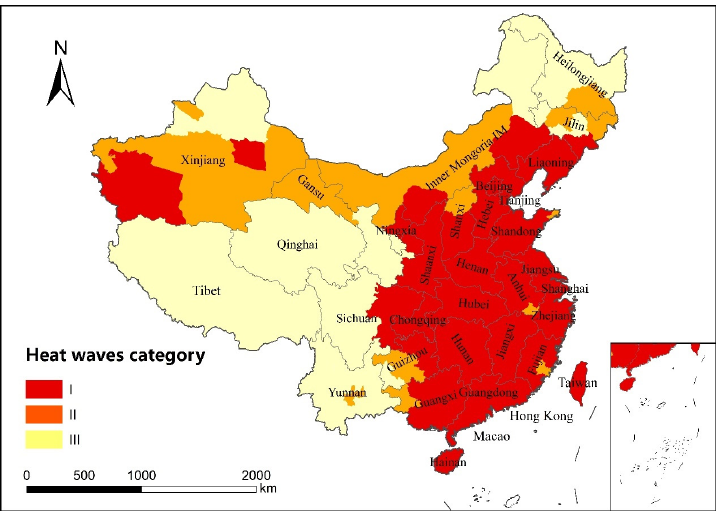
Figure 6. Distribution of cities during the heat wave period from 24 July 2019 to 28 July 2019. The UTCI values and corresponding thermal comfort levels of the five selected mo- ments (8:00, 11:00, 14:00, 17:00, and 20:00) with frequent human activity during the typical heat wave were analyzed. According to the UTCI classification standards for thermal comfort, the UTCI average values of each city during the heat wave were divided into four levels (Figure 7). The UTCI average during the heat wave showed an obvious trend of higher in the southeast and lower in the northwest. There were 39 cities with a UTCI average >38 °C (corresponding to “very hot” thermal comfort level), distributed in the middle and lower reaches of the Yangtze River and the Beijing–Tianjin–Hebei region. This is because the sub-high-pressure belt moves to the Yangtze River area in summer, the airflow sinks, and the temperature rises in the middle and lower reaches of the Yangtze River. However, the Beijing–Tianjin–Hebei region has long sunshine duration, high energy demand and con- sumption, high urban surface temperature, and a significant urban heat island effect. There were 184 cities with UTCI between 32.01 and 38.00, which were distributed in East China. This is because the eastern region is located in a subtropical monsoon climate and temperate monsoon climate zone with high temperatures and rainy summers. There were 52 cities with UTCI <26 °C, distributed in Northeast, Northwest, and Southwest China.